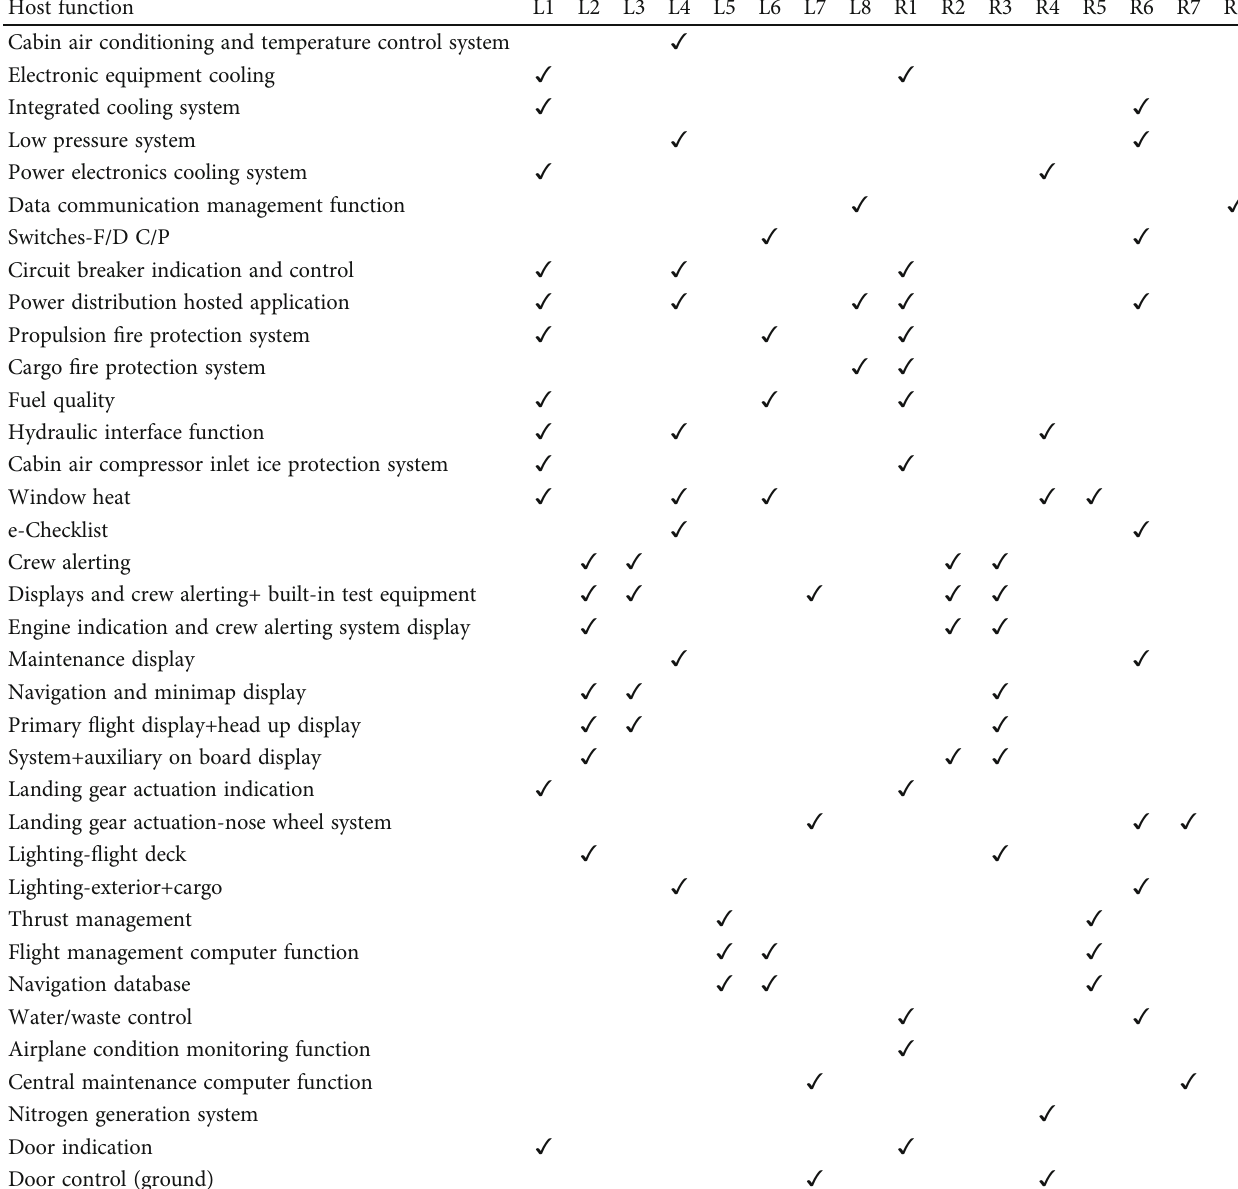
Table 2: Resource allocation scheme of B787 IMA